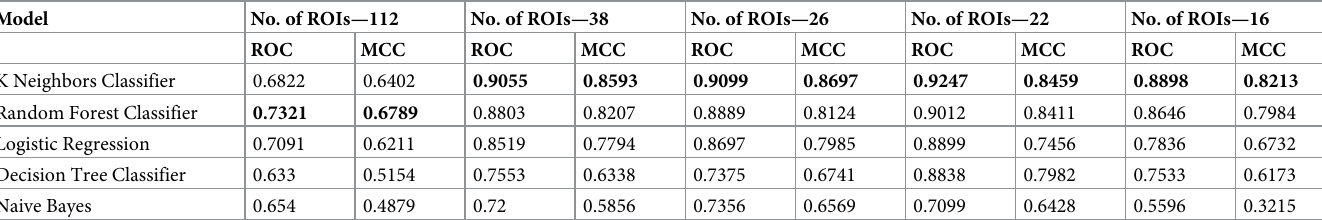
Table 1. ROC and MCC across different ROIs for the classification shown by various models. Model